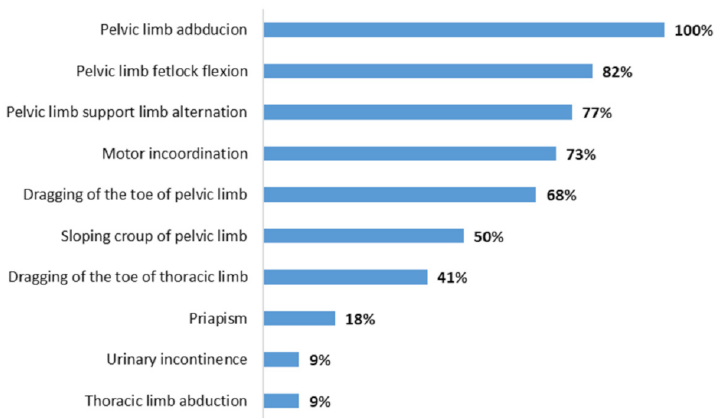
Figure 1. Main neurological signs in horses with equine herpesvirus myeloencephalopathy in the state of Par á , Amazon, Brazil.